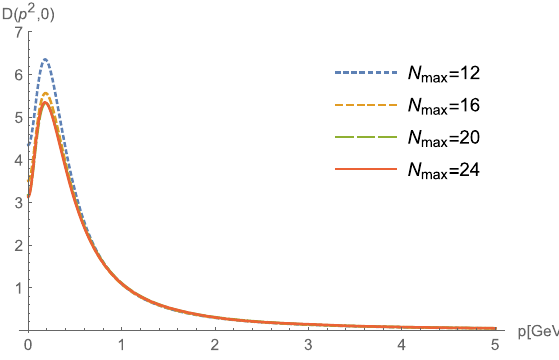
Fig. 4 The gluon propagator with the Hermite functions of truncation order N max = 4 n